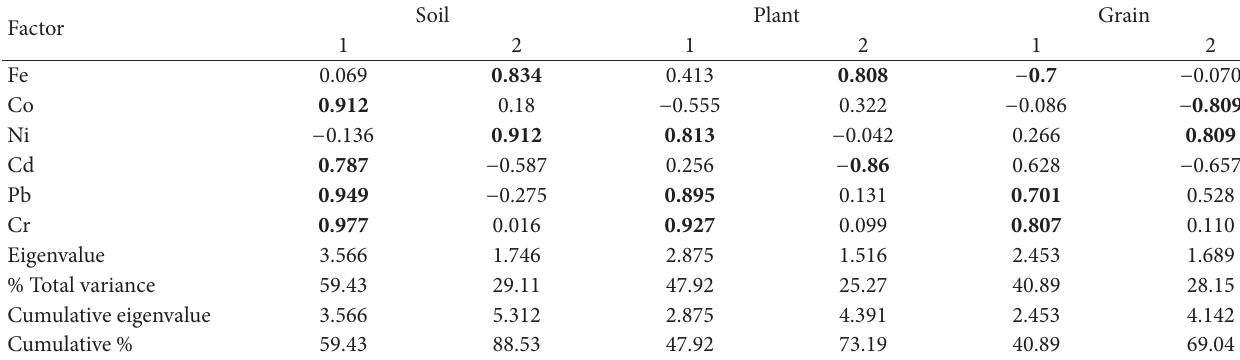
T 6: Varimax normalized factor loadings for metals in soil, plant, and grain samples. Factor